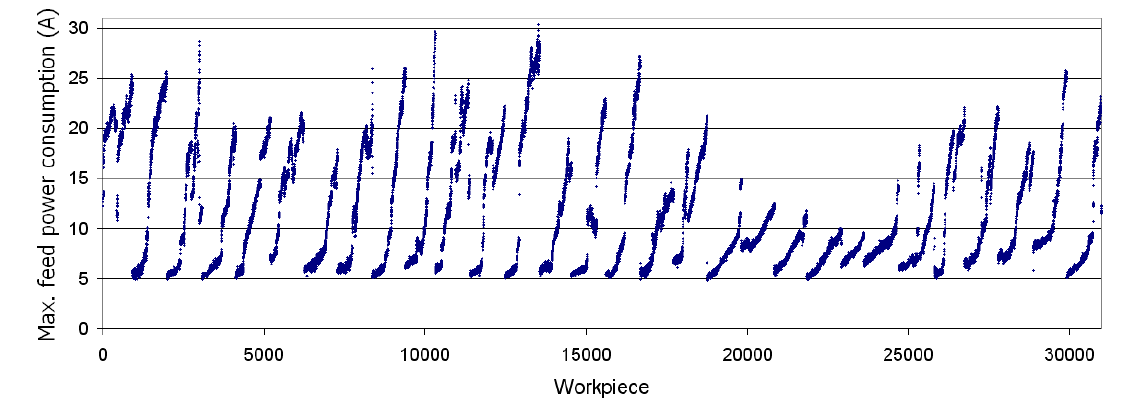
Data set used for the evaluation of the performance of the virtual sensor, representing the electrical power consumption of more than 30,000 mechanized